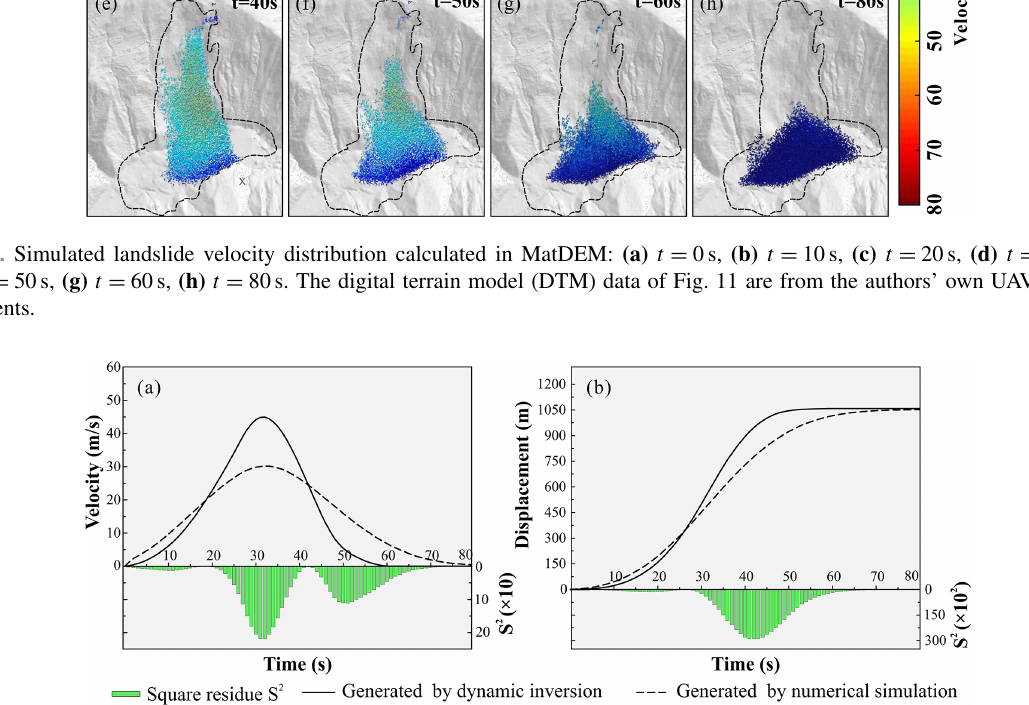
Figure 12. Comparison of landslide characteristics simulated using discrete-element model with inversion results: (a) average velocity and (b) average displacement.